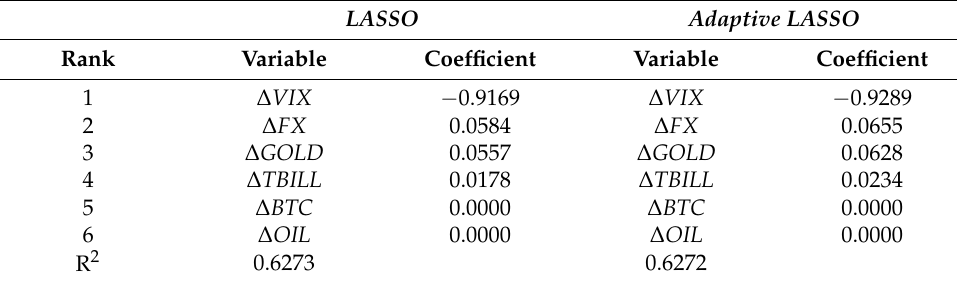
Table 3. Estimated coefficients of the LASSO